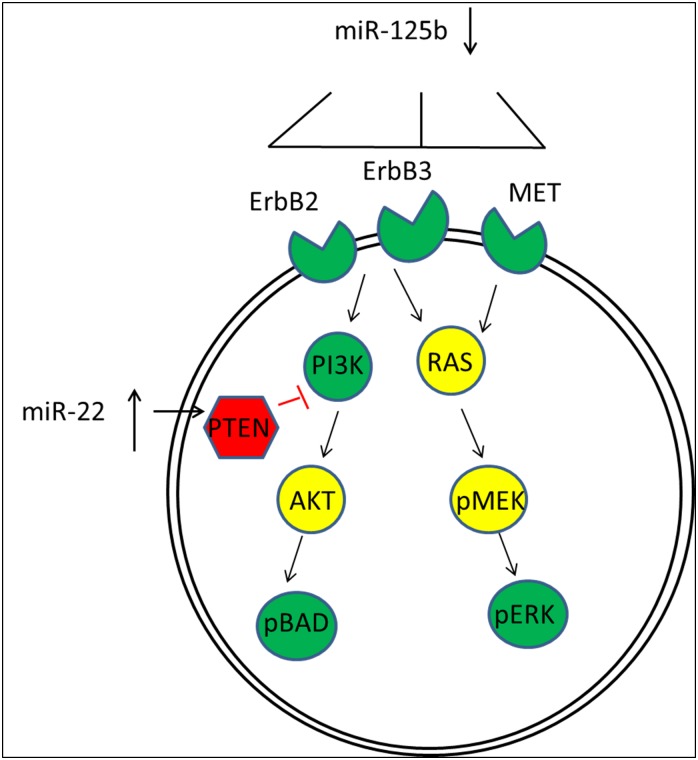
Model for dual regulation by miR-125b and miR-22.RPPA data shows increases in ErbB3, ErbB2, MET, PI3K, pBAD and pERK protein expression in M12 cells relative to the parental p69 cell lines (Table 3: green targets). Western blot (Fig 4D) confirms a decrease in PTEN expression (red). These proteins figure prominently in signal transduction pathways that are targeted by miR-125b and miR-22. Intermediates in yellow (AKT, RAS and pMEK) were not included in the proteome analysis. miR-125b directly targets ErbB2, ErbB3 and MET and miR-22 targets PTEN [30,31]. We propose that the loss of tumor suppressor miR-125b in the M12 cell line would result in enhanced signaling via the PI3K/AKT pathway and the RAS/pMEK pathway as regulated by MET. Conversely, miR-22 targets PTEN, the loss of which by increased expression of miR-22 further exacerbates PI3K signaling. In this scenario the dysregulation of these two miRs could contribute to the highly tumorigenic/metastatic phenotype displayed by the M12 cells compared to the parental p69 cell line and subsequently contribute to prostate tumorigenesis.